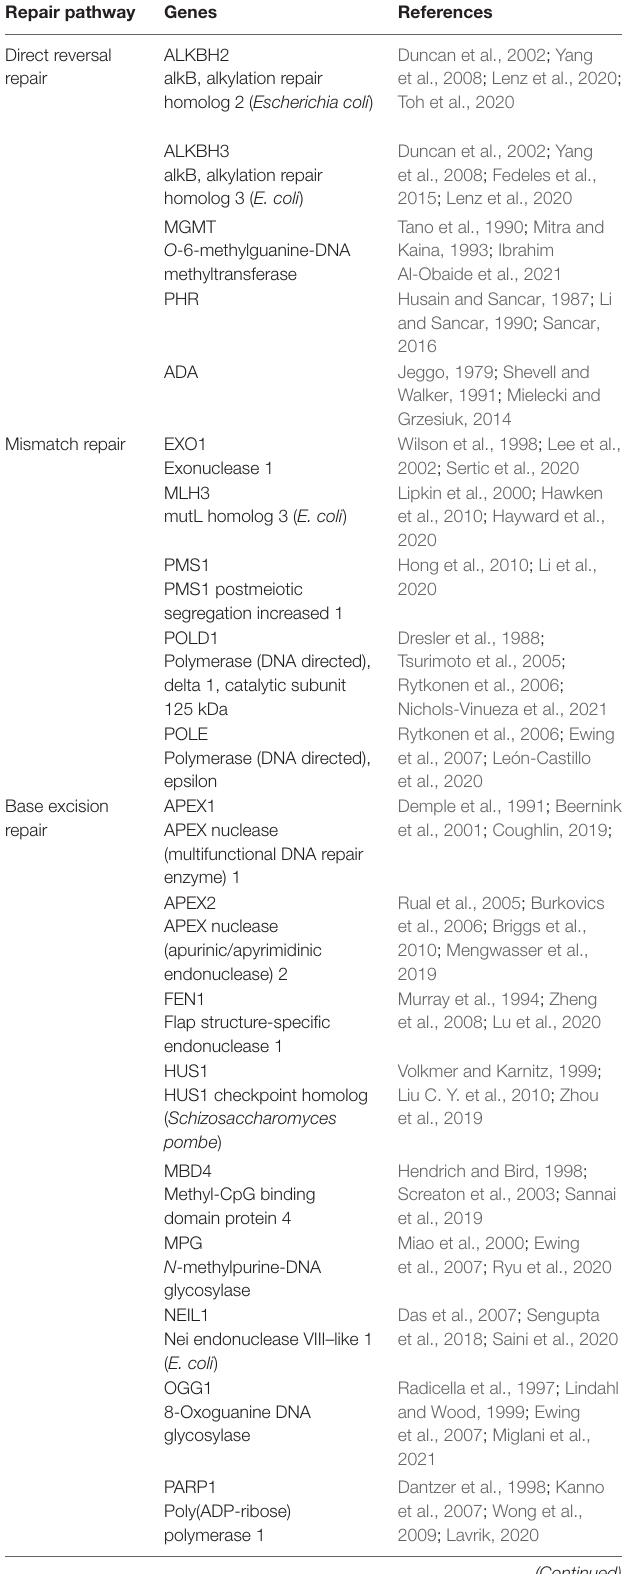
TABLE 2 | List of key genes that play vital roles in different DNA repair